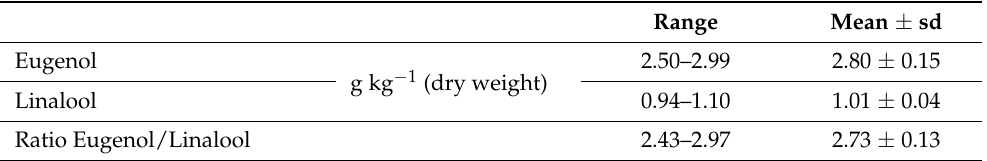
Table 3. Eugenol and linalool content in the 10 samples analysed: concentration ranges, mean values, standard deviation (sd) and ratio between eugenol and linalool.